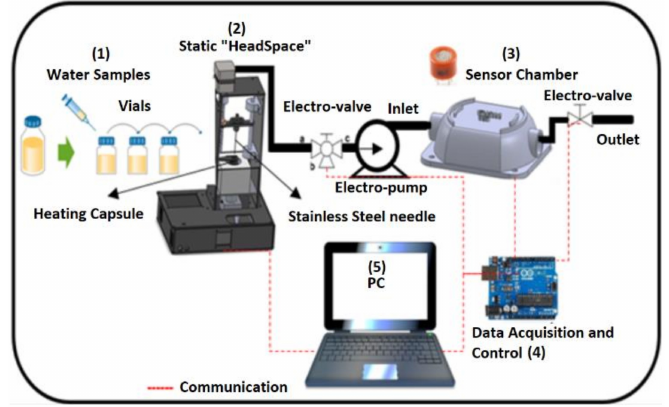
Figure 1. General scheme of the methodology.